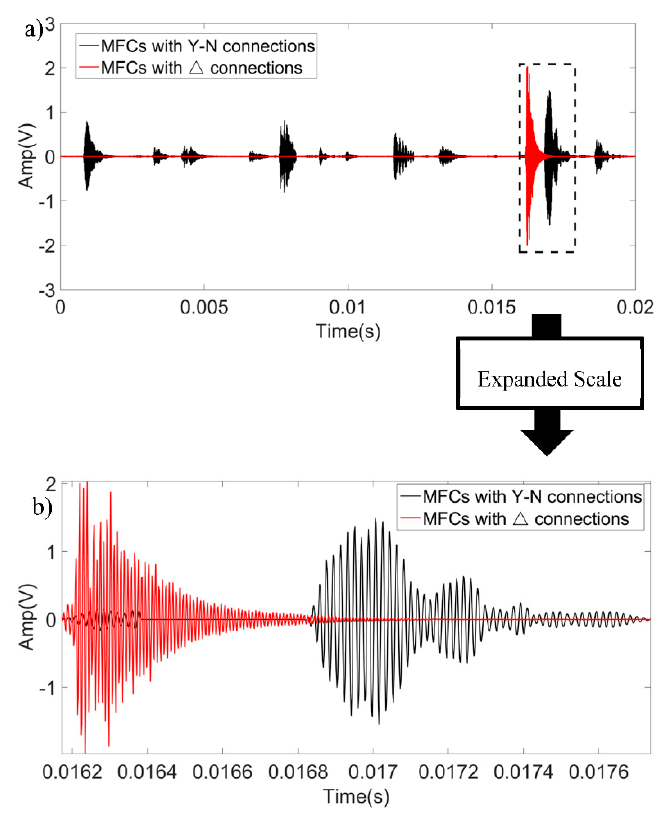
Figure 12. Waveforms of self-healing discharges in MFCs with di ff erent connections: ( a ) total shape, ( b ) shape of a single discharge.